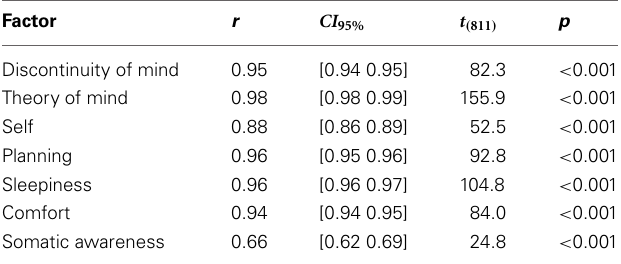
Table 6 | Descriptive statistics of correlations between mean scores and estimated model factor scores.